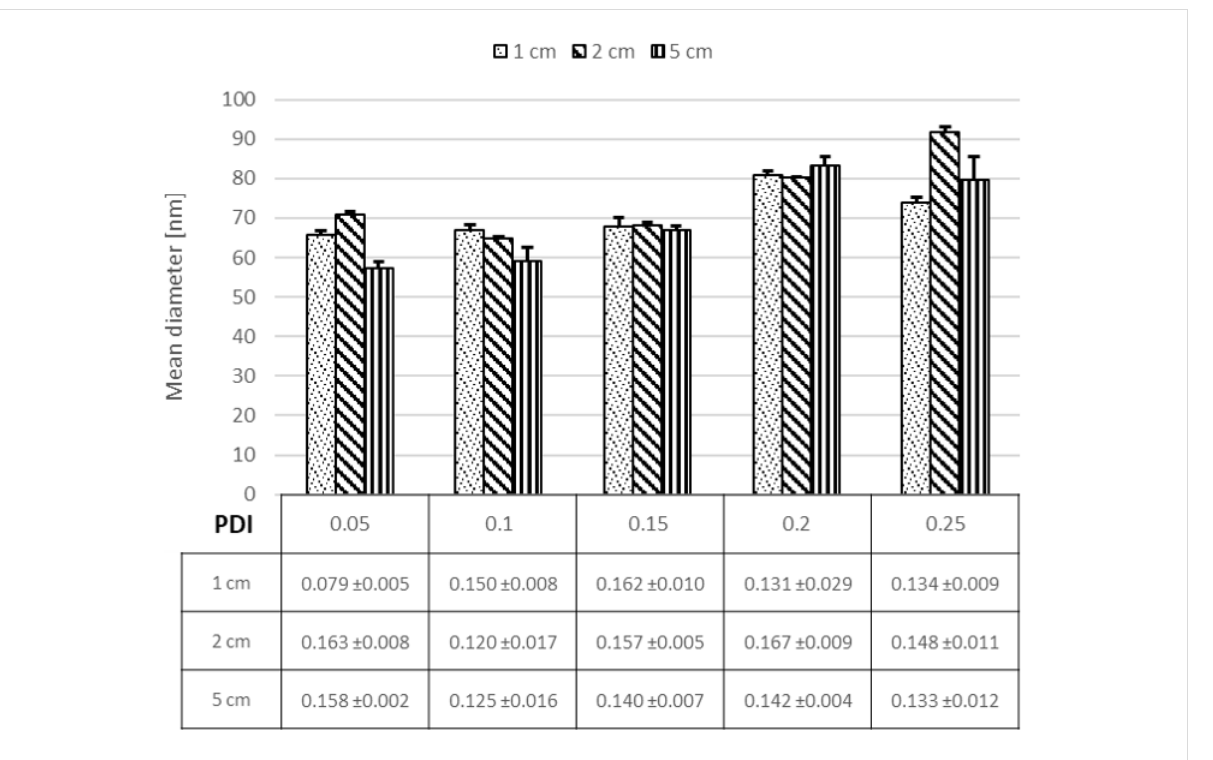
Figure 7: Effect of using different mixing channel lengths (1 cm, 2 cm and 5 cm) on the NP size and size